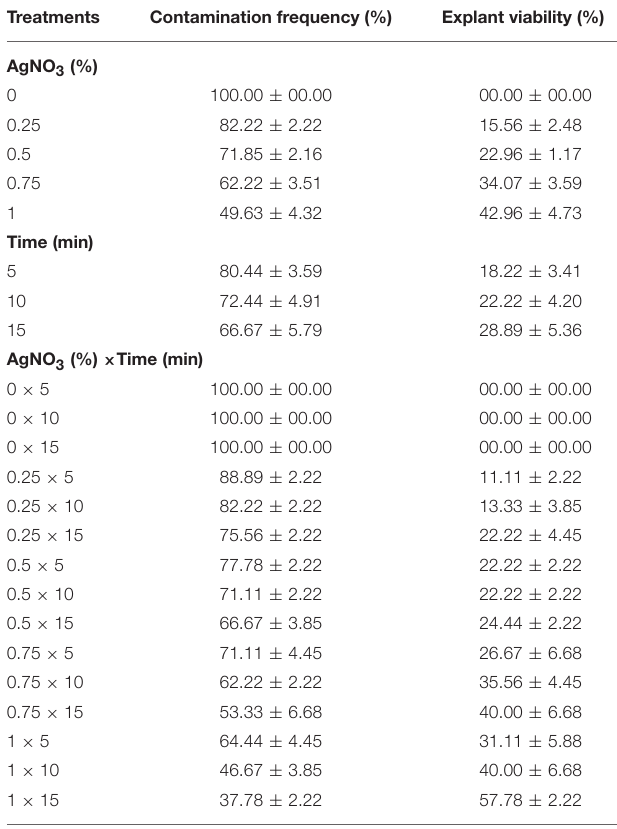
TABLE 4 | Effect of different concentrations of H 2 O 2 at various immersion times on in vitro sterilization of chrysanthemum. Treatments